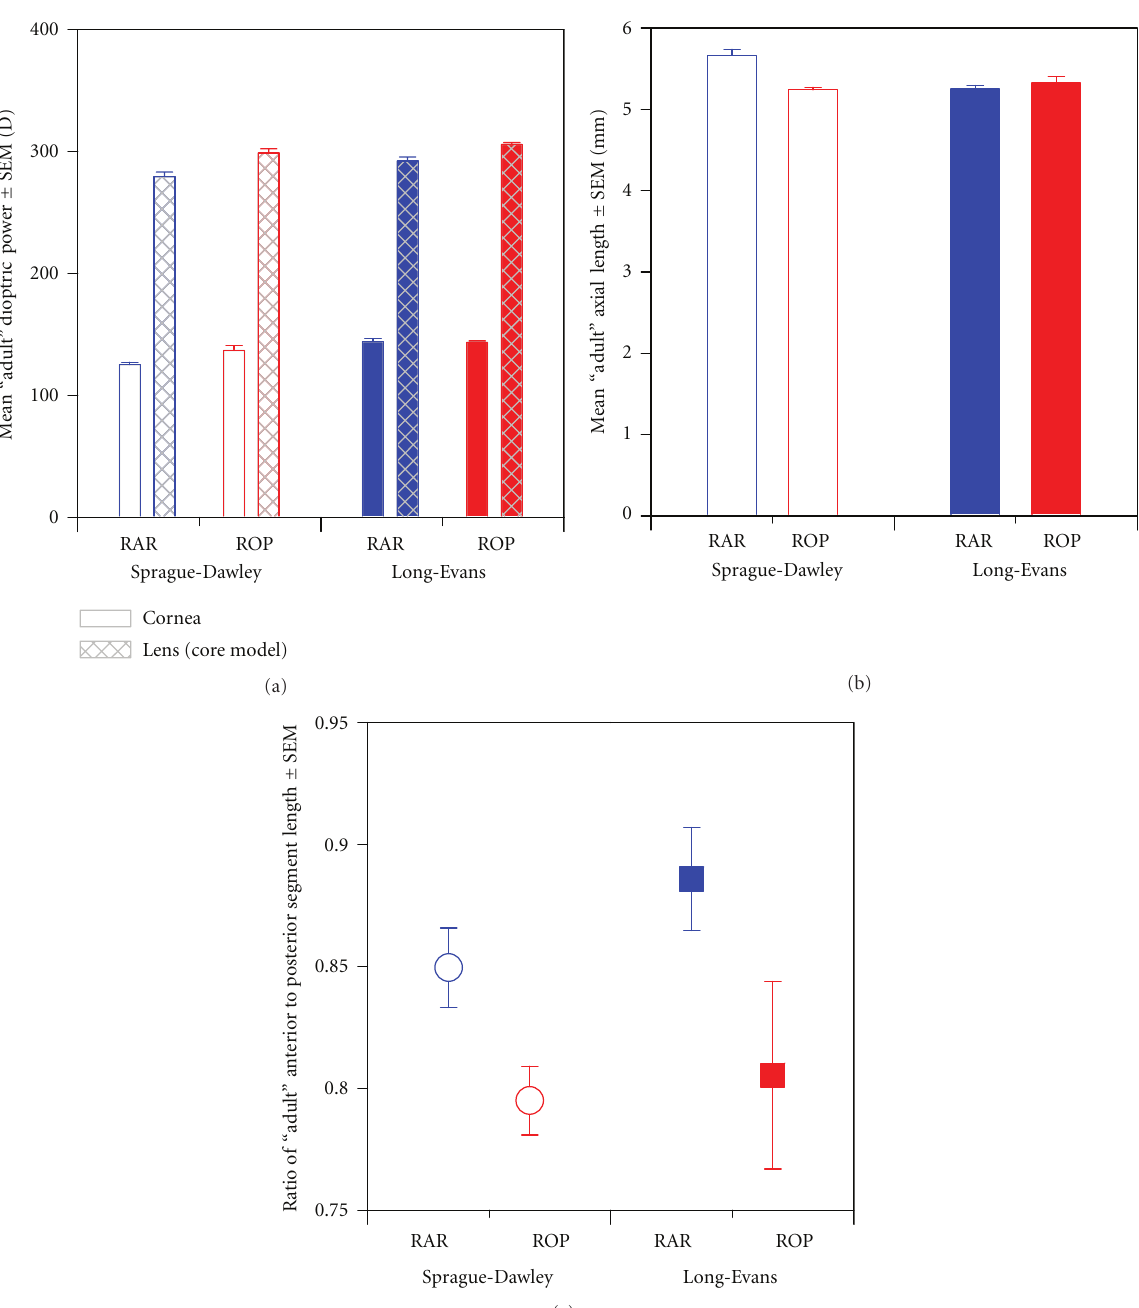
Figure 5: Biometric bases of R (cid:2) at ∼ P50. (a) Dioptric power of the cornea and lens. (b) Axial length ( d ). (c) Quotient of anterior segment length ( c ) divided by posterior segment length ( h